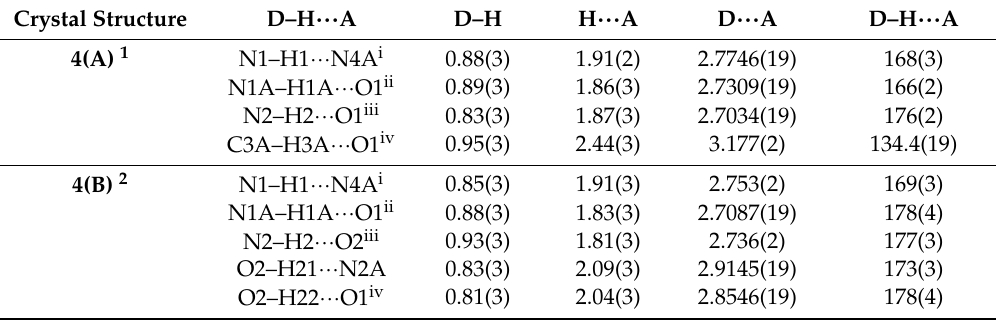
Table 1. Hydrogen-bond geometry (Å, °) for 4(A) and 4(B) . Crystal